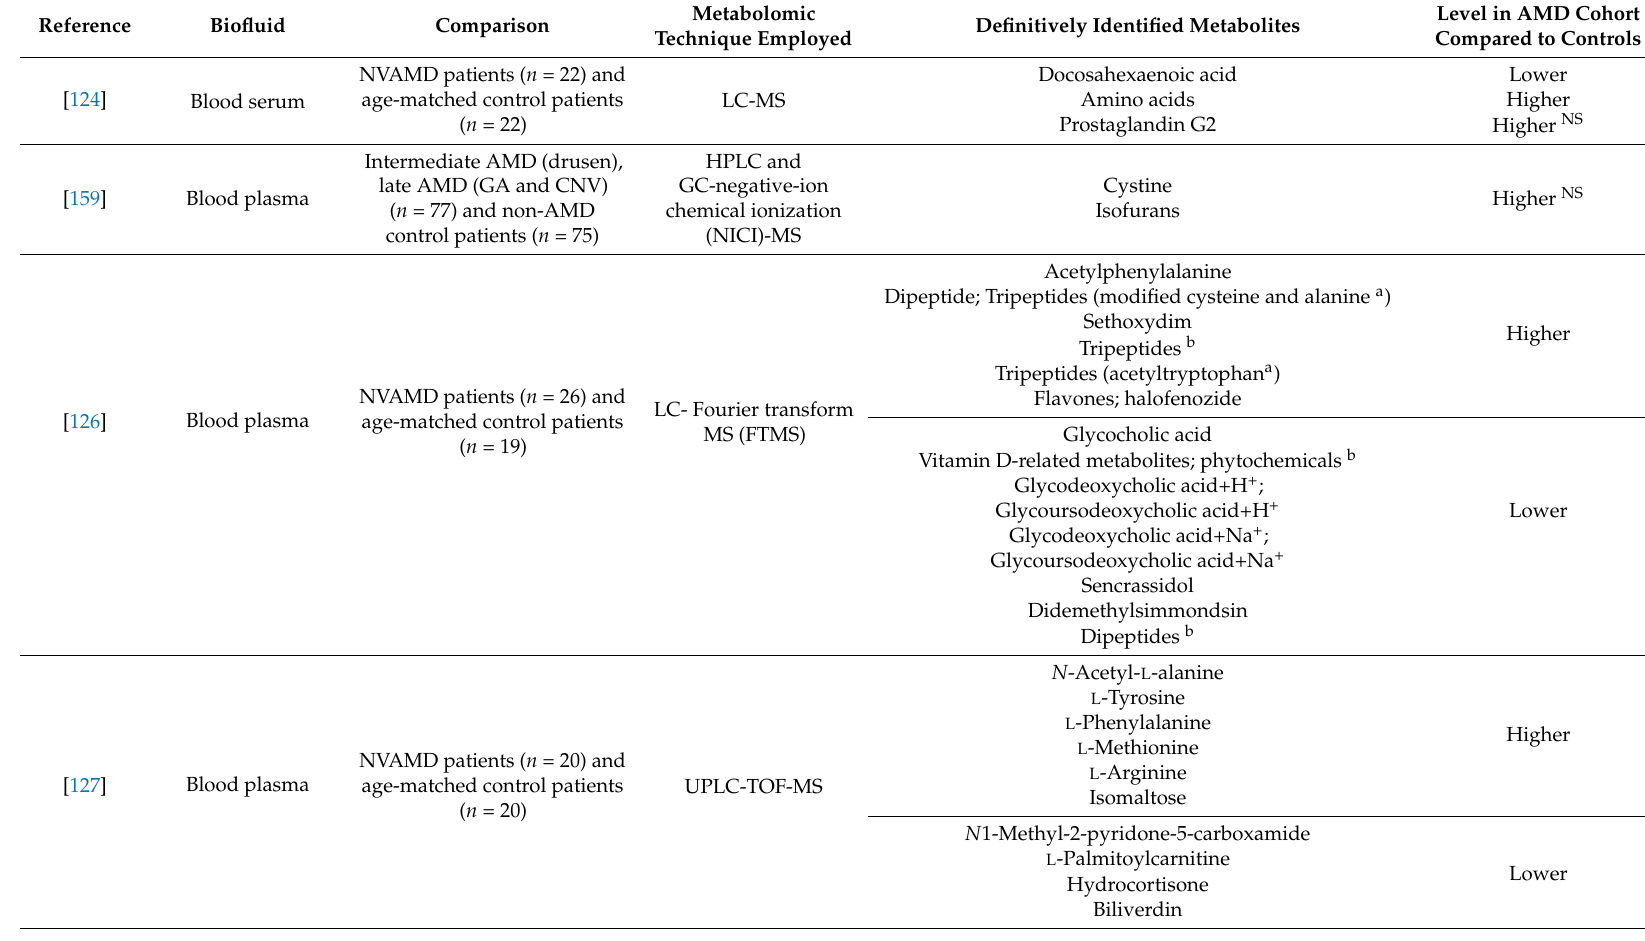
Table 2. Metabolites in human biofluids differing between AMD patients and control individuals. The number of individuals assessed in each study is indicated in